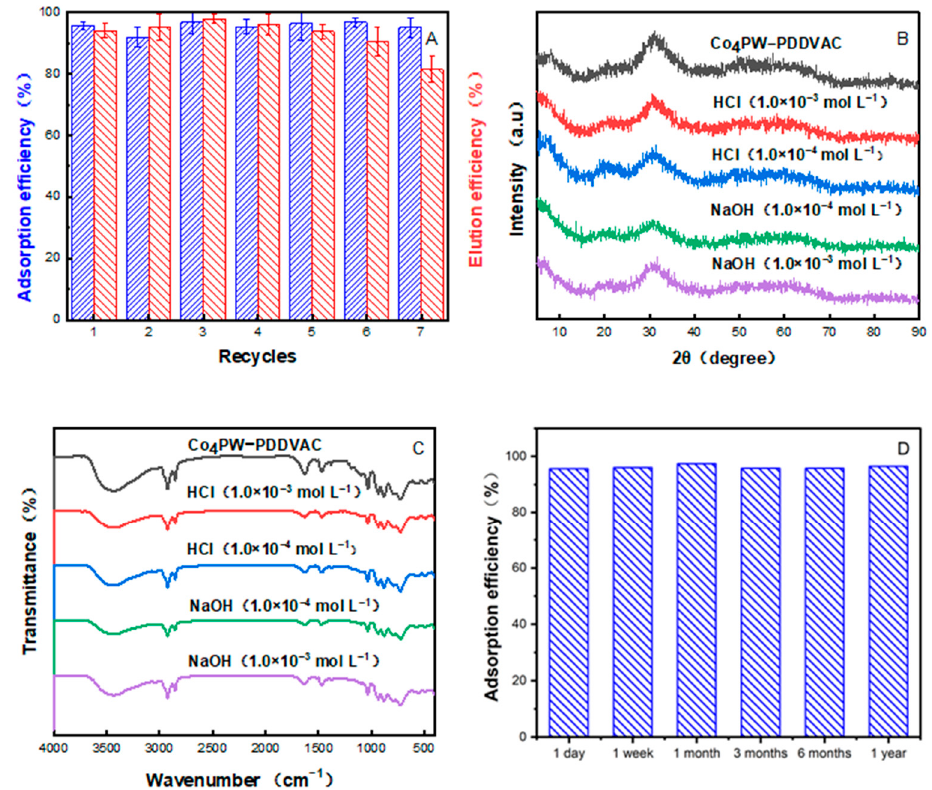
Figure 7. ( A ) The reusability of Co 4 PW–PDDVAC composite. XRD patterns ( B ) and FTIR spectra ( C ) of Co 4 PW–PDDVAC composites under different chemical circumstances for 24 h. ( D )